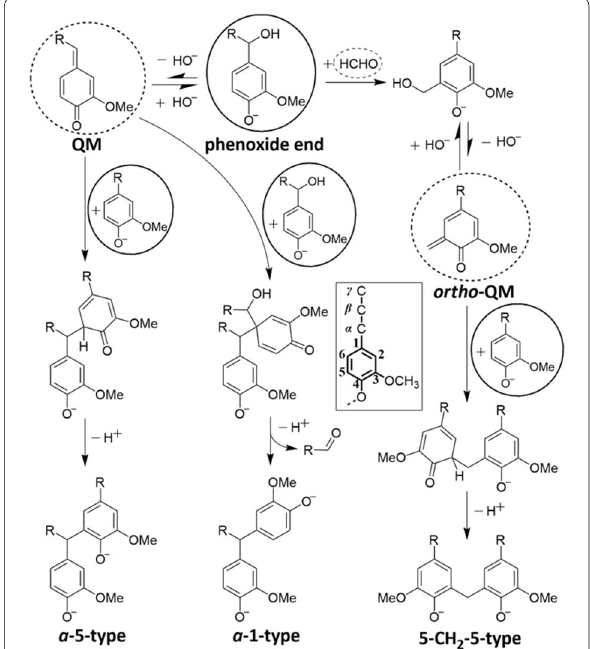
Fig. 2 Progress of the β - O -4 bond cleavage in model compounds of α -5- and α -1-type condensation substructures.